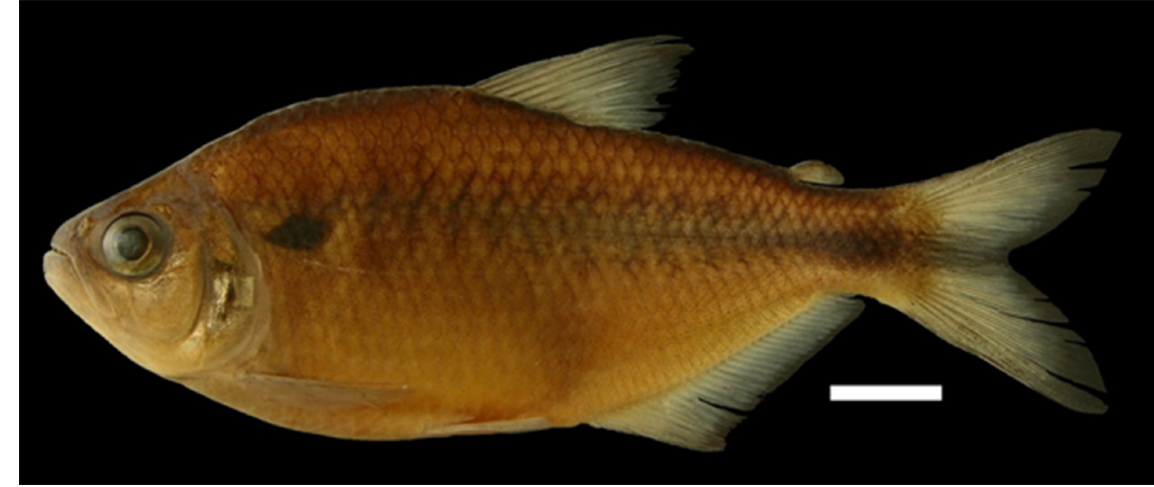
Fig. 5. Astyanax boliviensis sp. nov., paratype, 79.0 mm SL, Colonia San Carlos River, Isiboro, Mamoré, Bolivia (UMSS 5282). Scale bar =